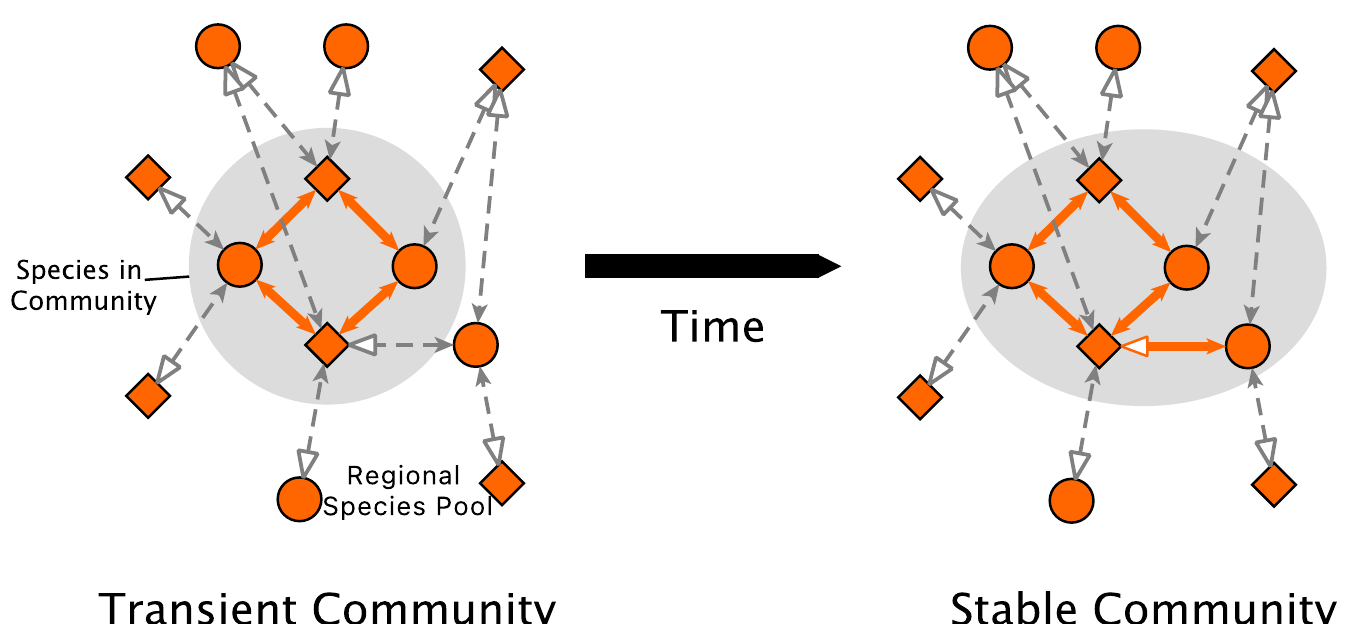
Fig 1. The community assembly model of Campbell et al. [72]. Interactions between plants (diamonds) and pollinators (circles) are shown with arrows; beneficial interactions are shown with filled arrowheads and detrimental interactions are shown with unfilled arrowheads. Species present in the community are shown inside the gray shaded region; species in the regional species pool (i.e., species that may colonize if conditions become favorable) are positioned outside the shaded region. Interactions involving species in the regional species pool do not affect species in the community of interest and are shown with dashed gray connections; interactions between species in the regional species pool are omitted for visual clarity. (Left) An example of a transient (i.e., unstable) community consisting of two plant species and two pollinator species present in the community. While the four species are self-sufficient, one additional pollinator species from the regional species pool is poised to colonize the community by virtue of its beneficial interaction with the bottom plant species. (Right) According to the dynamic update process described in Eq [1], the pollinator species is able to colonize the community on the subsequent time step. This community is considered stable because no other colonization or extinction events will occur from this